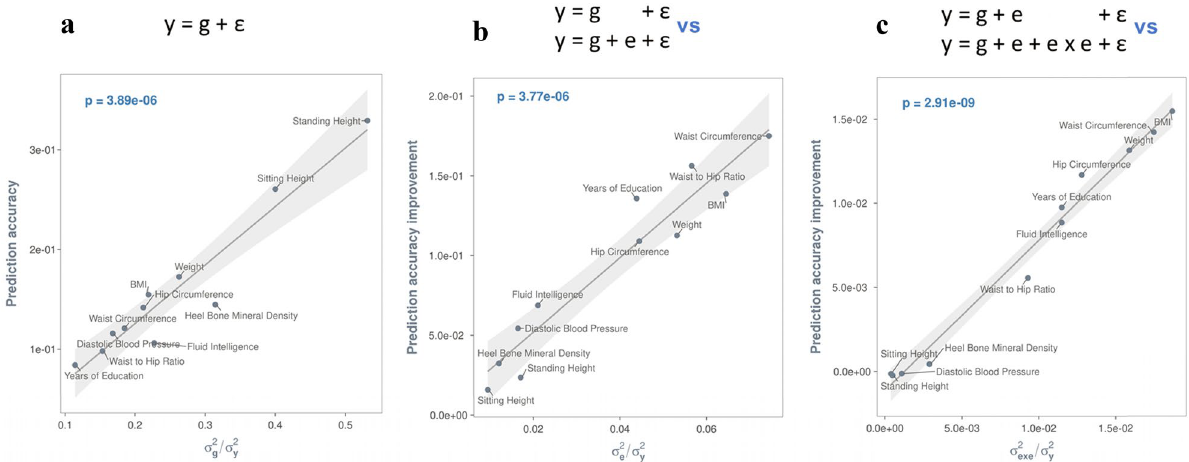
Figure 2. Exposomic variables contribute to phenotypic variance and improve phenotypic prediction accuracy. The prediction accuracy of a given model was computed using the Pearson’s correlation coefficient between the observed and the predicted by the model. For all panels, the least squares line with 95% confidence band is based on a linear model that regressed either prediction accuracies ( a ) or predication accuracy improvements ( b , c ) by a model on variance component estimates of the model. The p-value is for the t-test statistic (df = 7) 2 under the null hypothesis that the slope of the regression line is zero. σ g = phenotypic variance explained by 2 σ 2 additive effects of the genome; σ e = phenotypic variance explained by additive effects of the exposome; exe = 2 phenotypic variance explained by exposome-by-exposome interactions; and σ y = total phenotypic variance. ( a ) Phenotypic prediction accuracies by the baseline model that uses genomic data alone, i.e., y = g + ε, where g = phenotypic effects of the genome and ε = residuals. The larger the genetic variance, the greater the prediction accuracy. ( b ) Additive effects of the exposomic variables (i.e., e) contribute to phenotypic variance and improve phenotypic prediction accuracy. The greater the additive effects, the larger the gain in phenotypic prediction accuracy. A prediction accuracy improvement (on the y-axis) was derived by subtracting the prediction accuracy of the model y = g + ε from that of the model y = g + e + ε. ( c ) Exposome-by-exposome interactions (i.e., exe interactions) contribute to phenotypic variance and further improve phenotypic prediction accuracy. The greater the variance estimate of exe interactions, the larger the gain in phenotypic prediction accuracy. A prediction accuracy improvement (on the y-axis) was derived by subtracting the prediction accuracy of the model y = g + e + ε from that of the model y = g + e + exe +